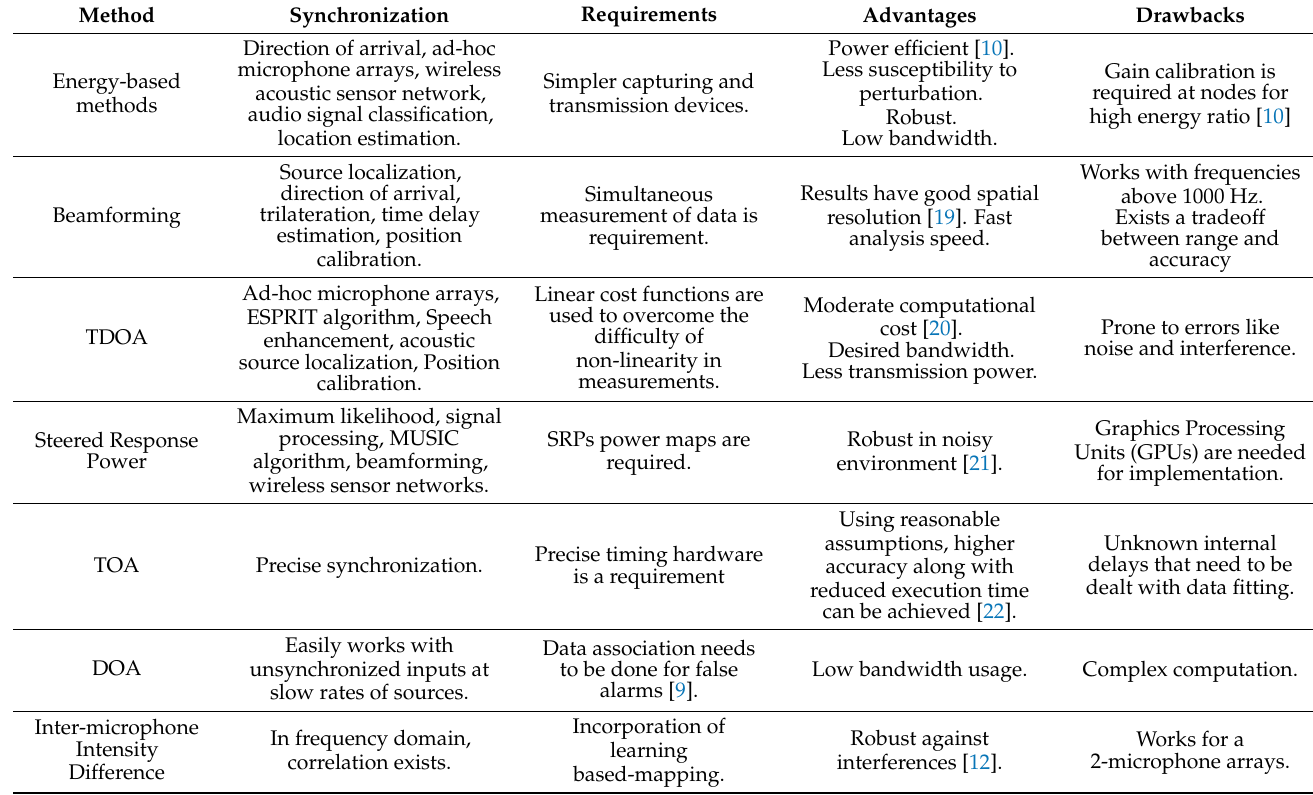
Table 4. Comparative study of sound localization